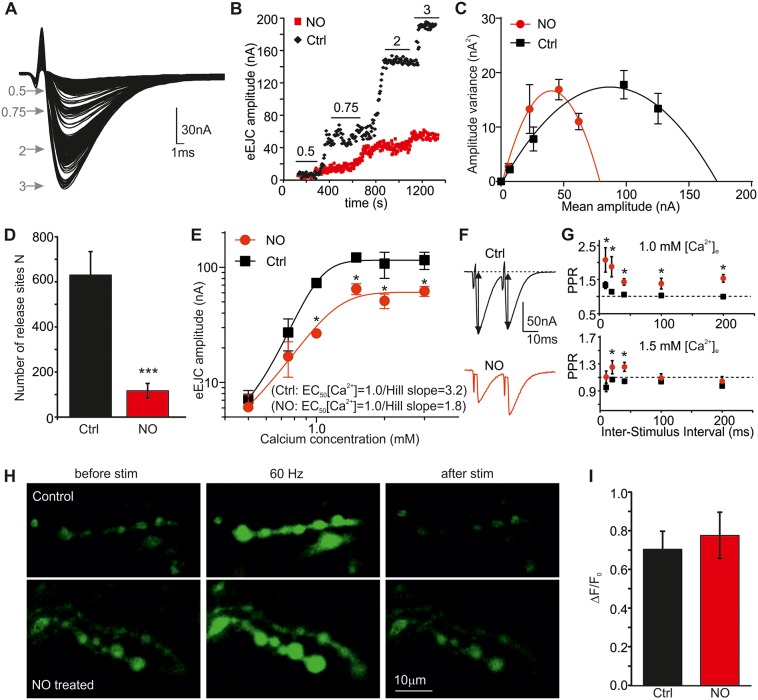
Ca2+ dependency of evoked release is reduced by NO.(A) Representative raw eEJC recordings at different [Ca2+]e (from 0.5 to 3 mM). (B) Time course of single eEJCs for 2 NMJs (w1118 Ctrl and NO exposure) at indicated [Ca2+]e. (C) Parabolic fits to the variance-mean relationships for the conditions indicated. (D) N estimated from fluctuation analysis in both conditions. (E) Ca2+ cooperativity of evoked release is shown on a double logarithmic plot for w1118 Ctrl and NO. (F) Raw traces for PPRs of a Ctrl and NO-treated NMJ at 1.0 and 1.5 mM [Ca2+]e, illustrating a reduced release probability following NO exposure. (G) Summary of PPR at 1 and 1.5 mM [Ca2+]e for various ISI for Ctrl and NO (n = 5 larvae for Ctrl, n = 3 larvae for NO, with 2–3 NMJs per larva). (H) Images of myrGCaMP-expressing NMJs from a Ctrl (top) and a NO-treated larva (bottom) before, during (at 3 s, 60 Hz), and after the 8-s train. Changes in GCaMP5 fluorescence were analyzed for each bouton to calculate ΔF/F0. The raw data can be found in S3 Data. Values per NMJ were averaged and data denoting mean ± SEM for each condition of 6–8 NMJs (3–4 larvae) are shown in I. *p < 0.05, ***p < 0.001, Student t test. [Ca2+]e, extracellular calcium concentration; Ctrl, control; eEJC, evoked EJC; EJC, excitatory junction current; ISI, interspike interval; myrGCaMP, N-myristoylated GCaMP; N, number of release-ready vesicles; NMJ, neuromuscular junction; NO, nitric oxide; PPR, paired pulse ratio; stim, stimulation.